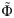
Gene co-expression weighted network heatmap: Heatmap representing the omega values of links for each network.The intensity of the color represents the weight of the link. Clusters of links that are stronger or weaker in certain groups of networks can be distinguished. Those clusters coincide with the CoDiNA Φ˜ subcategories shown on the left.